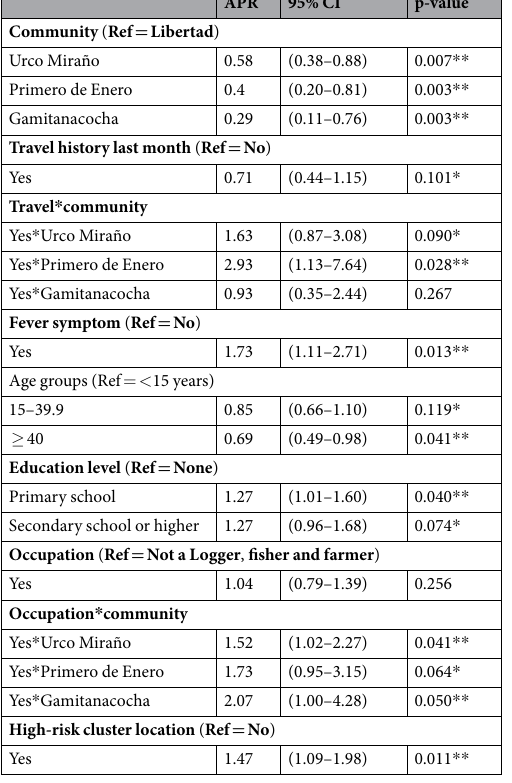
Table 4. Fixed effects of multi-community multivariate model for P . vivax parasitaemia. Mixed-effect Poisson Models; APR = Adjusted Prevalence Ratio; p-values and 95% CI adjusted by Adaptive False Discovery